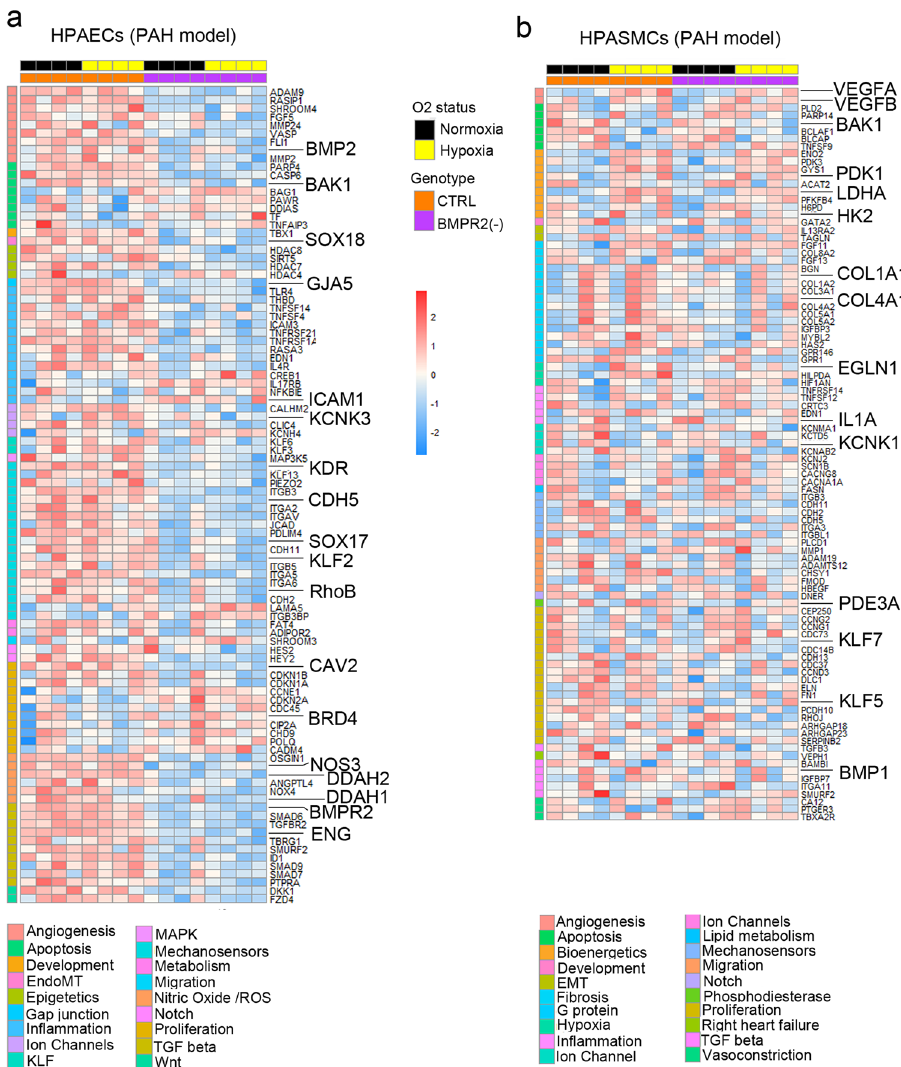
Fig. 3 PAH pathways in the two-hit disease model. Top DEG associated with cardiovascular diseases were grouped into categories and visualised as transcripts per million (TPM) heatmaps. Colour-coded pathways are shown underneath the heatmaps, with key gene symbols enlarged in a HPAECs and b HPASMCs. The genotype status (control and BMPR2 knockdown) and oxygen status (normoxia or hypoxia) are shown at the top of the heatmap in different colours, as indicated. Changes in gene expression are also colour coded, with blue denoting a lower relative gene expression and red denoting a higher relative gene expression. Each column represents 1 experimental repeat ( n =